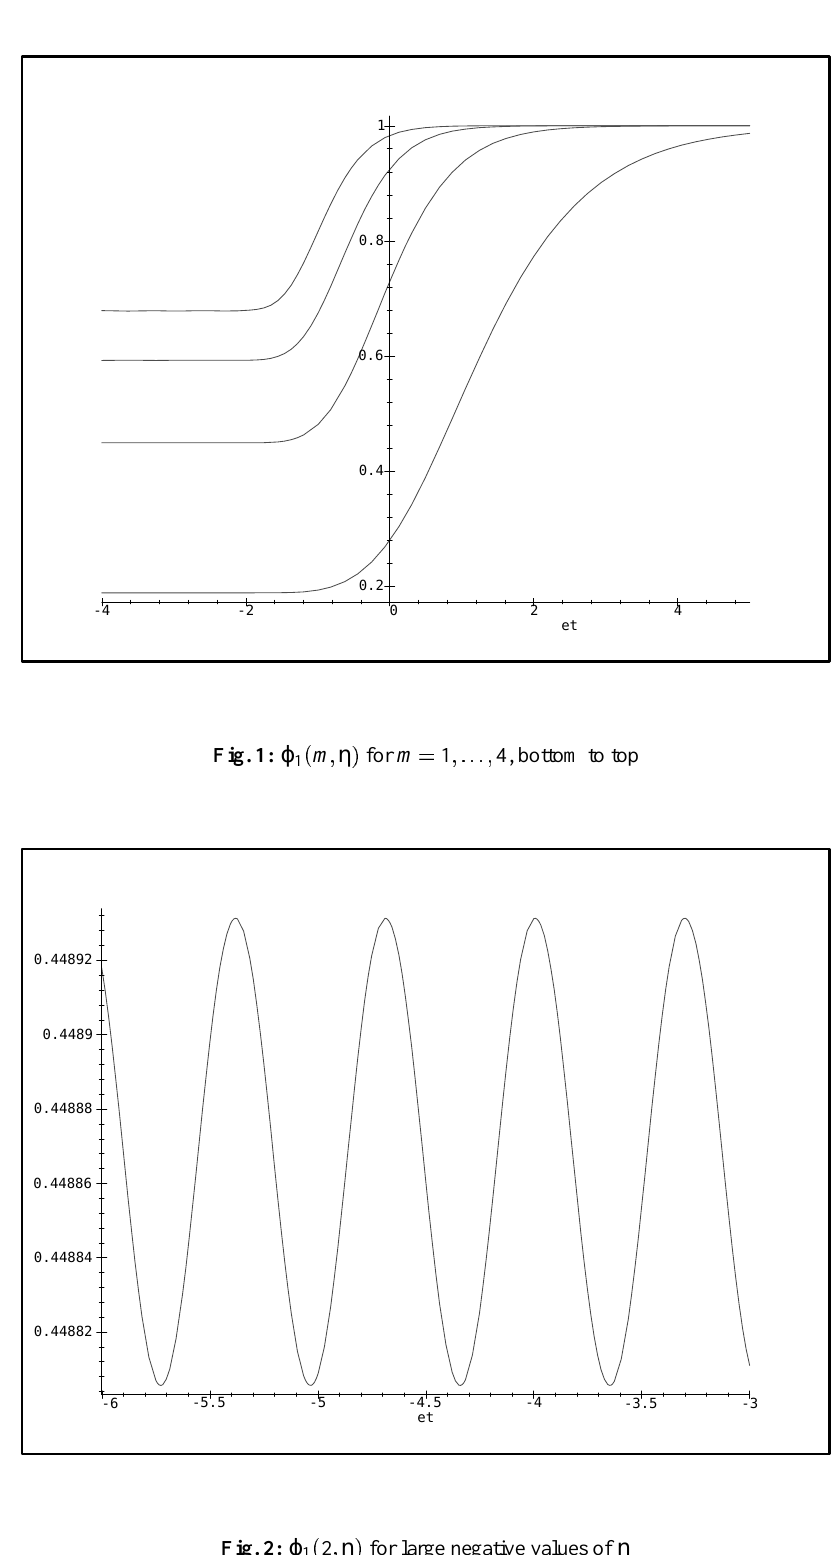
Fig. 2: j 1 (cid:0) 2